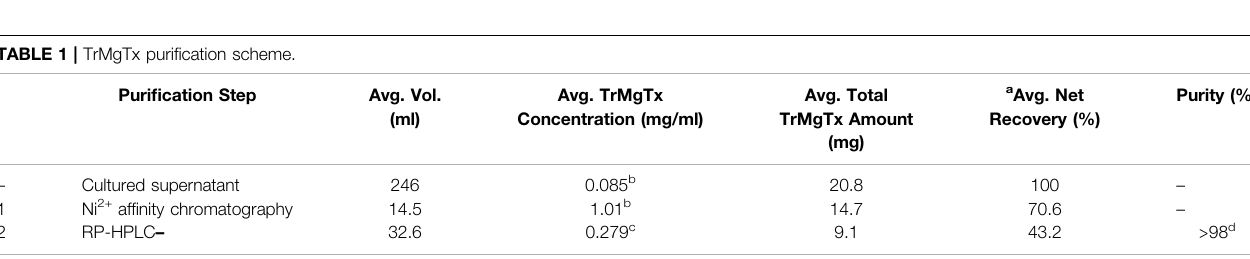
TABLE 1 | TrMgTx puri fi cation